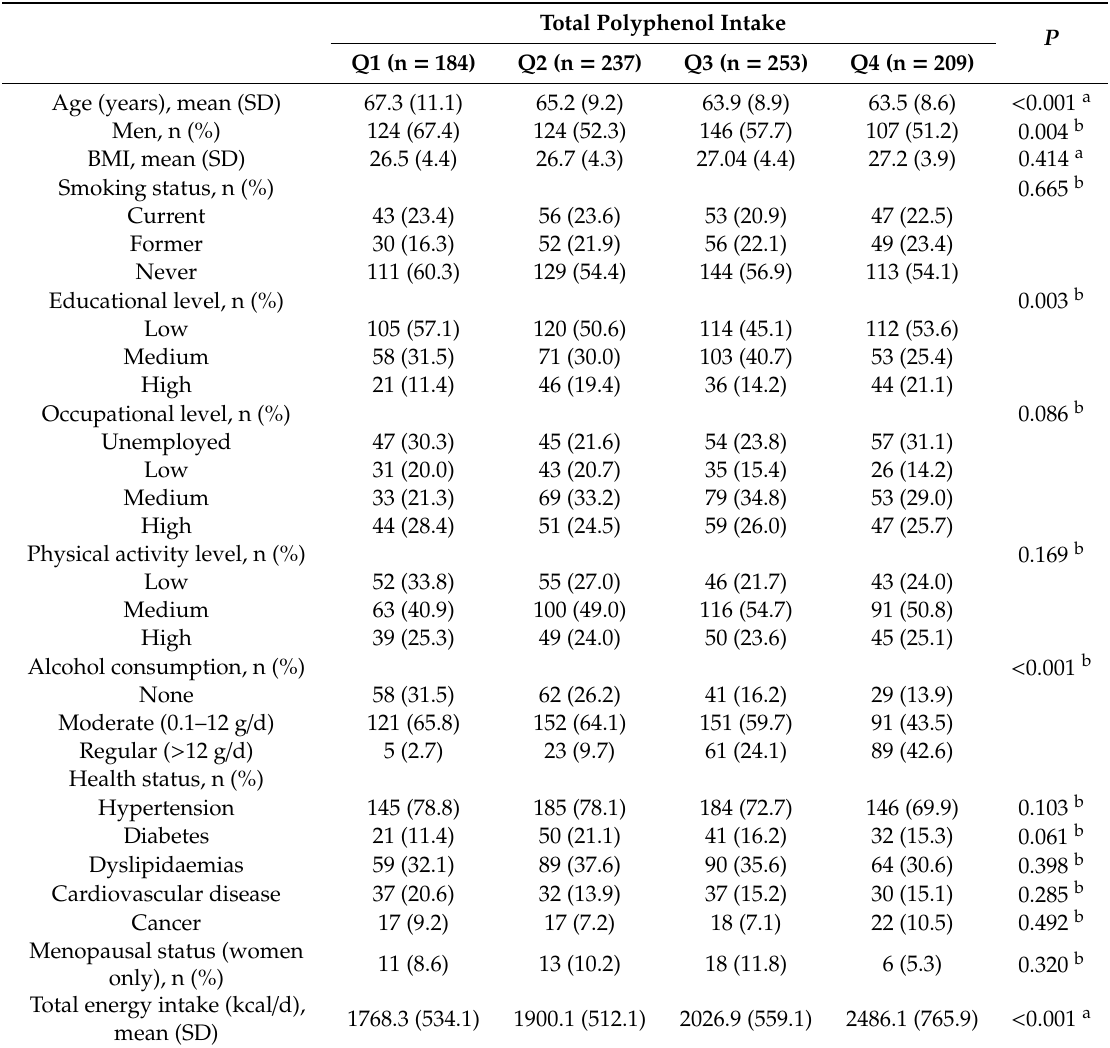
Table 1. Background characteristics of study participants by quartiles of total polyphenol intake